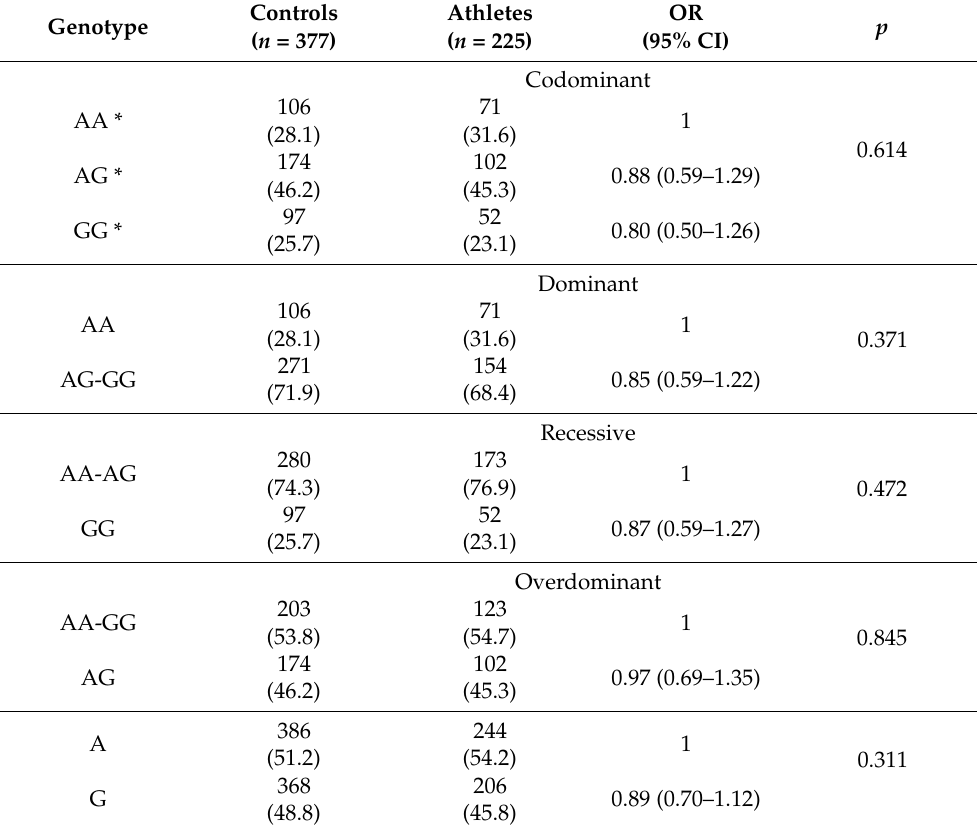
Table 2. Association analysis (genotypic and allelic) of the rs4689 COMT polymorphism with athletic